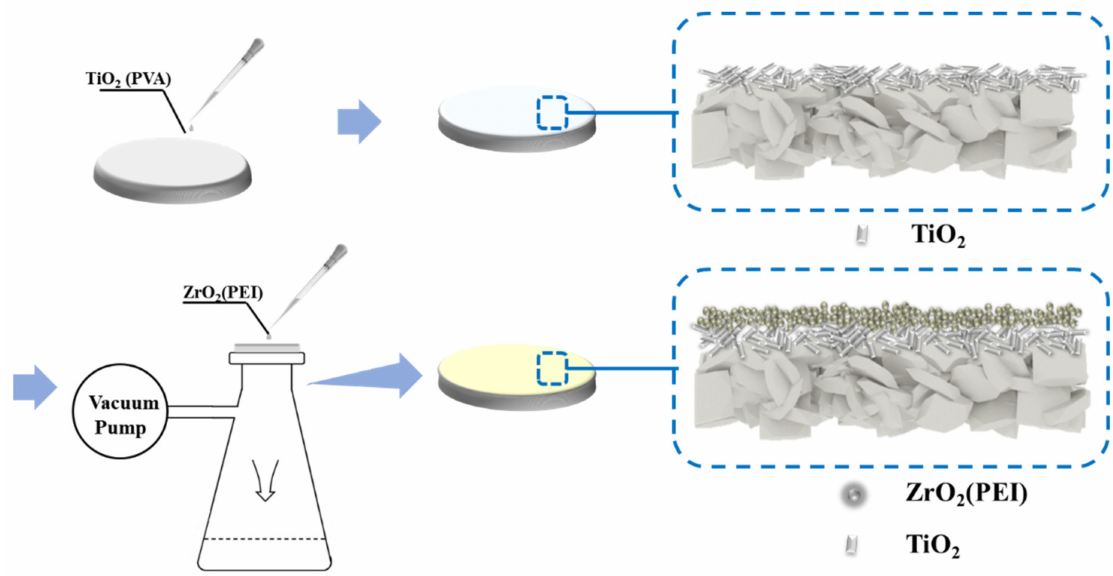
Figure 1. Schematic diagram of the ZrO 2 /TiO 2 /Al 2 O 3 composite membrane preparation